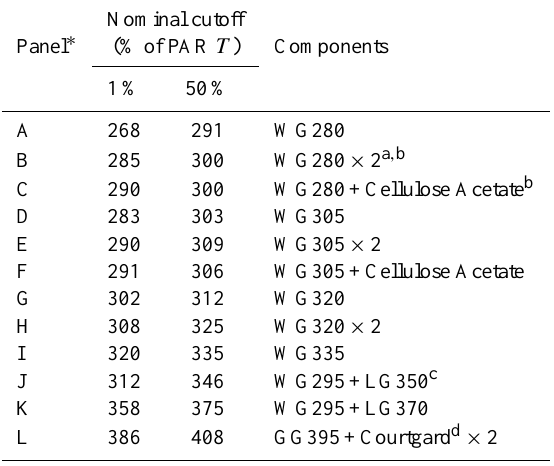
∗ Letters identify the panel in Fig. 2 with example results for the listed spectral treatment group. a All Schott filters were 3mm thick; “ × 2” denotes that two pieces of filter glass or film were combined, doubling the effective pathlength (thus red-shifting the cutoff wavelength, especially for 1% T ). b All filter combinations (either two pieces of filter glass or filter glass+film as indicated) were assembled with a high-purity silicone optical grease. This decreased variation in the index of refraction along the optical path and minimized scattering. Filter–filter or filter–film combinations had the same transmittance in the visible as single layer elements. c LG filters are manufactured by Corion and contain a polymer film sandwiched between two glass layers. The WG295 “prefilter” protected the polymer film from solarization by the short-wavelength irradiance from the xenon arc